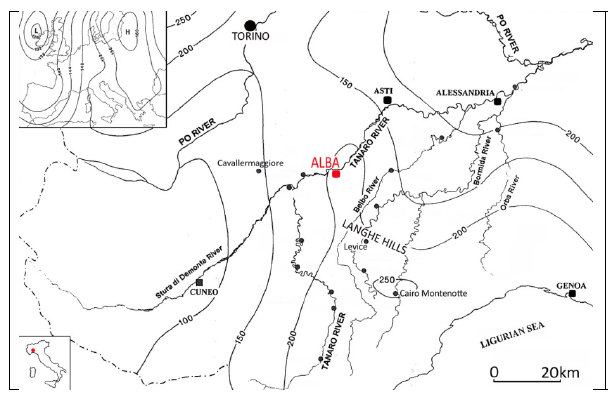
Fig. 1. Map of the Tanaro basin with the isohyetal (mm) pattern for 2.2. The Alba flood 2–6 November 1994. In the upper-left corner is a meteorological On November 5, 1994, beginning in midday, the first floods occurred along the Riddone stream and map of the conditions prevailing just before the catastrophic event Canale del Mussotto, severely flooding the Socchi and Mussotto quarters. At the same time, the Cherasca (4 November 1994, 24:00LT, 850hPa) (from the European Meteo- stream inundated part of the Bonomo quarter. The Talloria’s floodwaters overflowed on the right bank near rological Bulletin of the Deutscher Wetterdienst, the stream’s mouth, ran toward the town and, together with the Canale di Roddi waters, flooded several buildings in Le Basse quarter before striking the Piave and Vivaro quarters. During a second phase, the Talloria floodwaters reached the famous Ferrero plant at 5:30-6:00 p.m., filling the plant’s yards and buildings to a height of 60-70 cm. In the Piave quarter at the foot of the hill, basement flats and ground floors were flooded (20-40 cm) by the runoff coming from the saturated slopes or by the malfunctioning of the sewage system. In the following hours, the Tanaro inundation reached its paroxysmal phase (Fig. 2). The severe overflow and the violent passage of the waters over the ground left deep scour erosions on the left bank at the river’s confluence with the Talloria stream, near the sand-and-gravel separating plant, and on the right bank. The floodwaters spread into the Socchi area between 11:00 and 12:00 p.m. Similar severe processes affected the right bank, where the old levee broke and the waters cut deep scour erosions as they flowed around the large blockage created by the municipal dump. The floodwaters spreading out on the Topino plain were dammed by the embankment of the Asti-Cuneo highway, where they reached 5.6 m in height (Fig. 3). After the embankment gave way to the waters along the lower stretch, the flood struck Alba. At 10:30 p.m., violent waves burst into the Ferrero company plant, demolishing its external wall and inundating all of the buildings to a height of 2.80-3 m. Between 12:00 p.m. and 1:00 a.m. on November 6, the water in the lower zones of the Vivaro quarter was approximately 3.25 m deep. Meanwhile, on the left bank, the Tanaro waters overflowed the railway embankment to join the Riddone waters, reaching the Mussotto quarter (Fig. 4). Part of the Tanaro flow sought to return to the riverbed but was dammed by the highway embankment, raising the water level to 3.6 meters. The stretch of the Tanaro valley bottom between the confluence of the Talloria and Cherasca streams was flooded by a single expanse of water 2.5 km in width, on average.